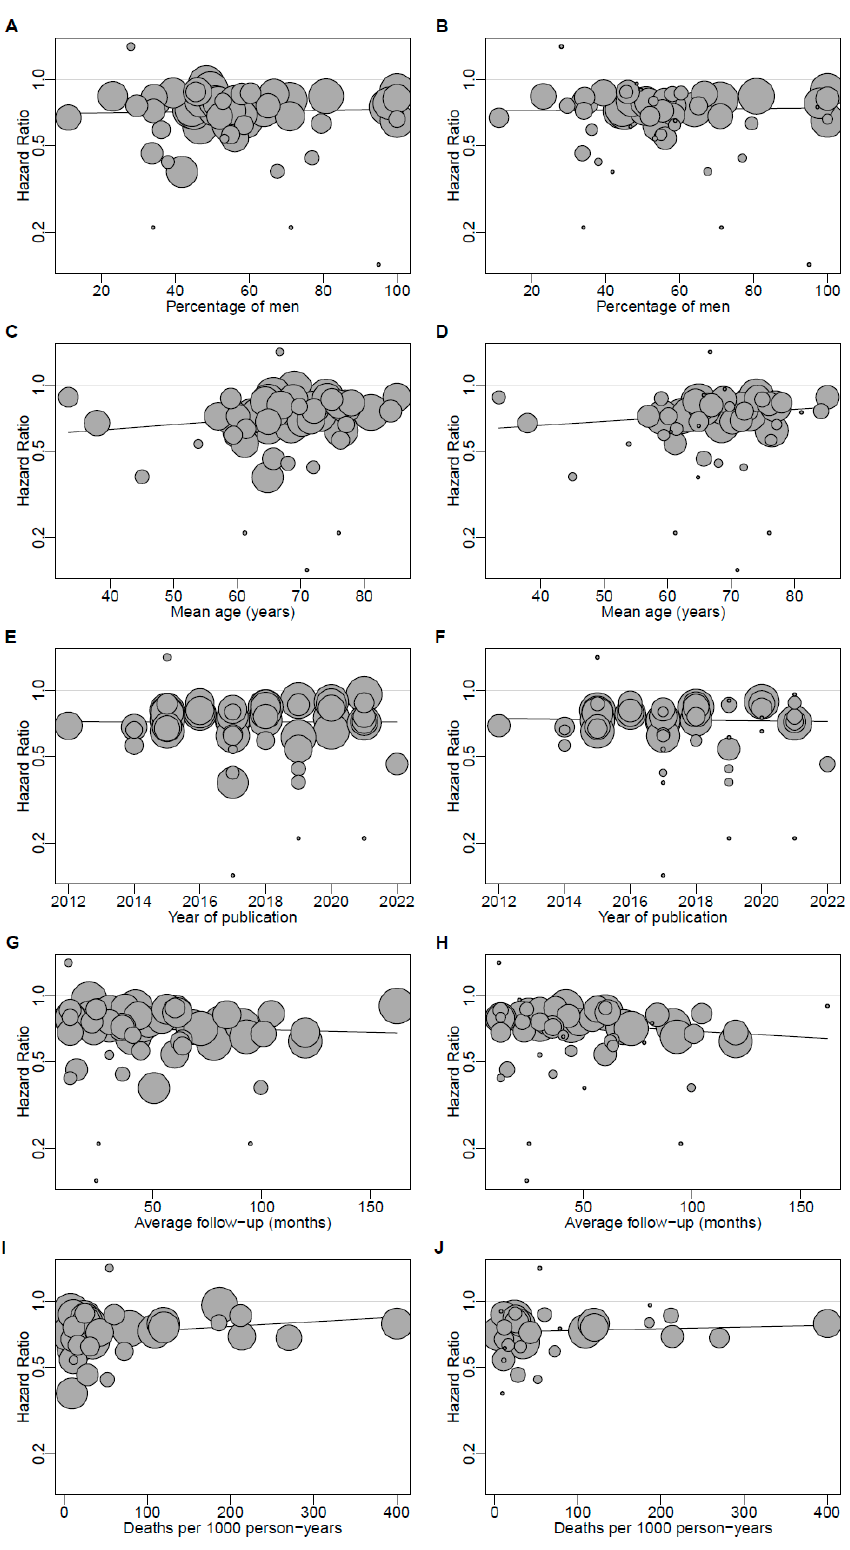
Figure 5. Bubble plots for the association between statin use and all-cause mortality regressed against the percentage of men ( A , B ), mean age ( C , D ), year of publication ( E , F ), average follow-up ( G , H ), and number of deaths per 1000 patient-years ( I , J ). Plots on the left represent the primary meta-analysis, whereas plots on the right represent the meta-analysis after the exclusion of influential studies. Bubble size represents study weight.